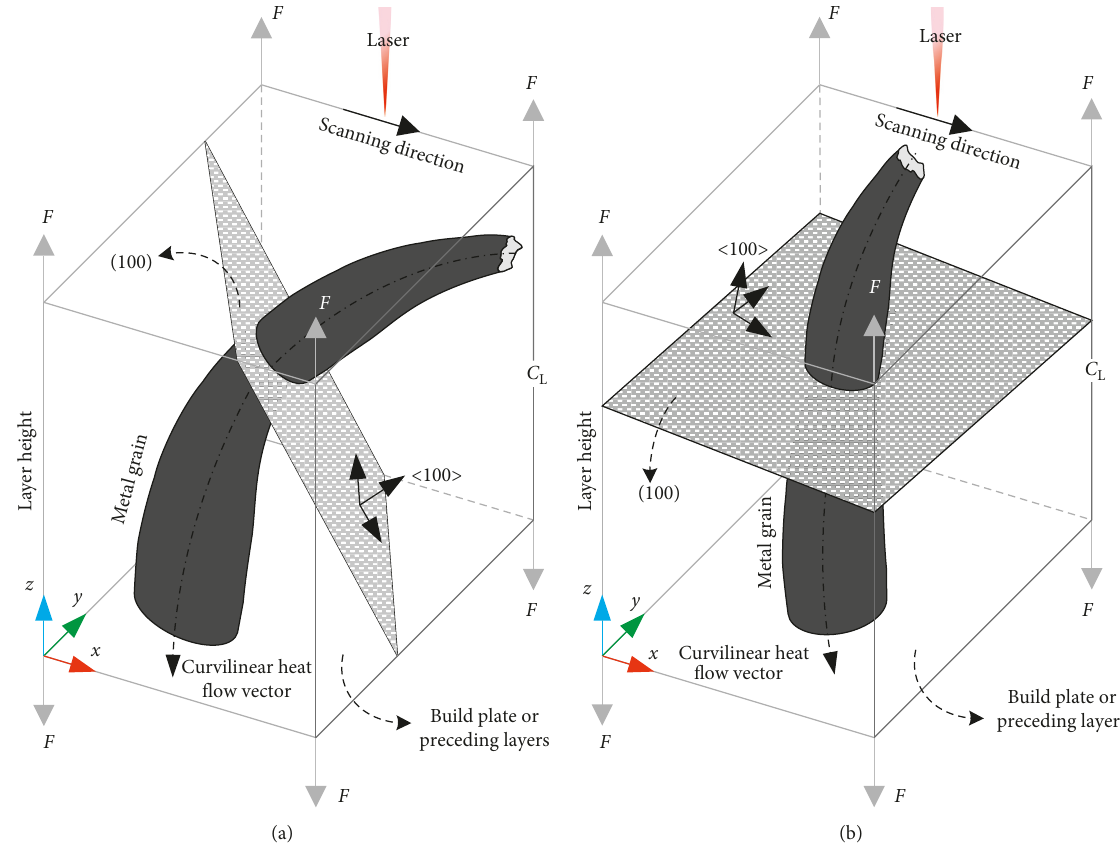
Figure 2: Differences in growth kinetics of metal grains along maximum heat flow. This schematic illustration shows two different grain positions with respect to the future loading conditions. In (a), the loading is close to the crystallographic < 111 > while in (b), the loading is close to < 100 >